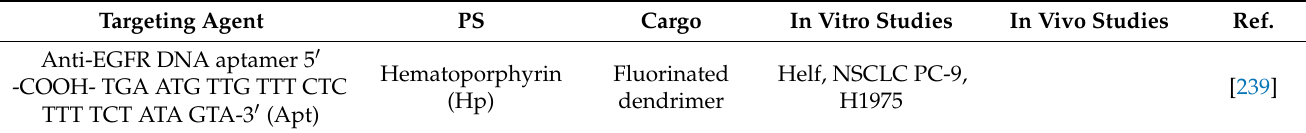
Table 15. EGFR-targeted PDT performed with an anti-EGFR aptamer conjugated with carrier molecules. Targeting Agent PS Cargo In Vitro Studies In Vivo Studies